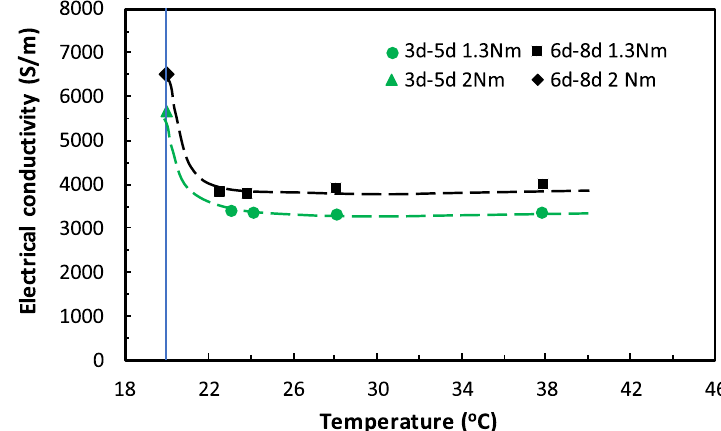
Fig. 12 Electrical conductivities of unpainted carbon/epoxy laminates in in-plane